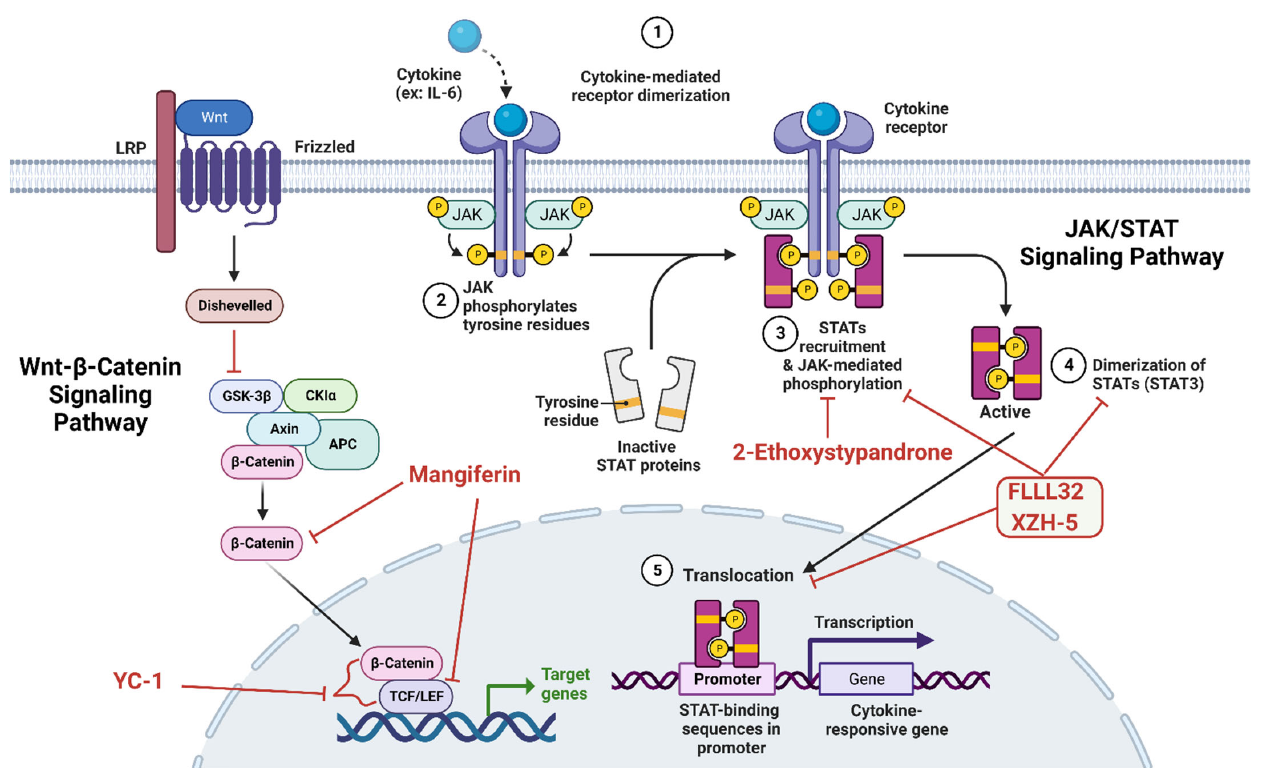
Figure 6. Schematic representations of emerging small molecule inhibitors of Wnt signaling pathway and STAT3 signaling pathway. This figure was generated by biorender. Wnt, Wingless and Int-1; TCF/LEF, T-cell factor/lymphoid enhancer-binding factor; GSK-3 β , glycogen synthase kinase-3 beta; APC, Adenomatous Polyposis Coli; LRP, lipoprotein receptor-related protein; JAK, Janus